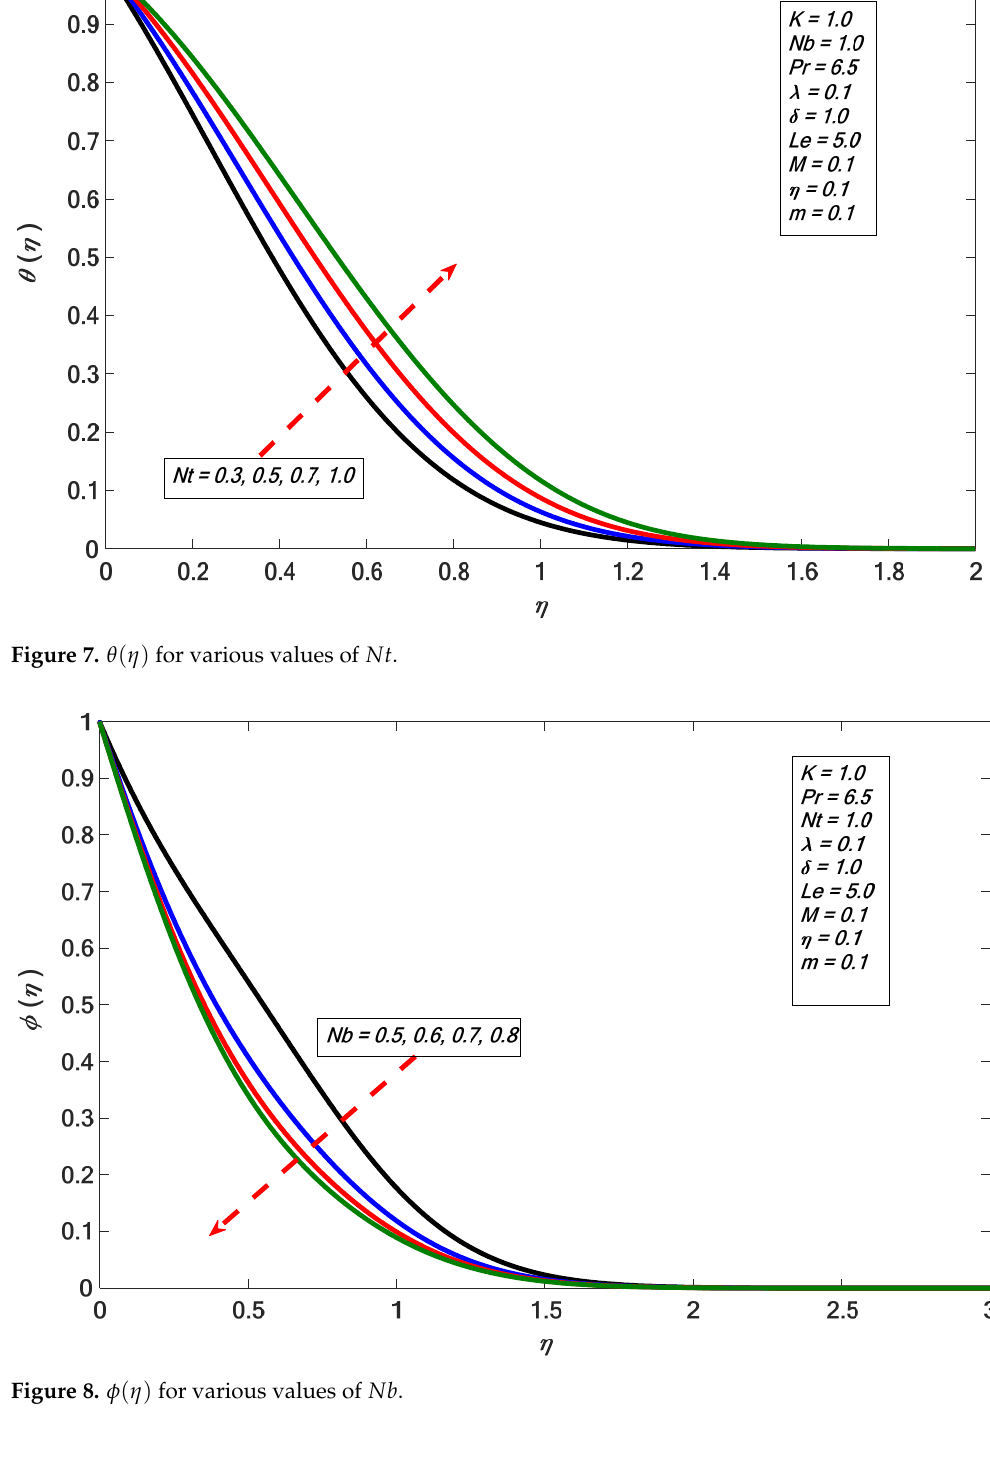
Figure 6. 𝜃(cid:4666)𝜂(cid:4667) for various values of 𝑁𝑏.